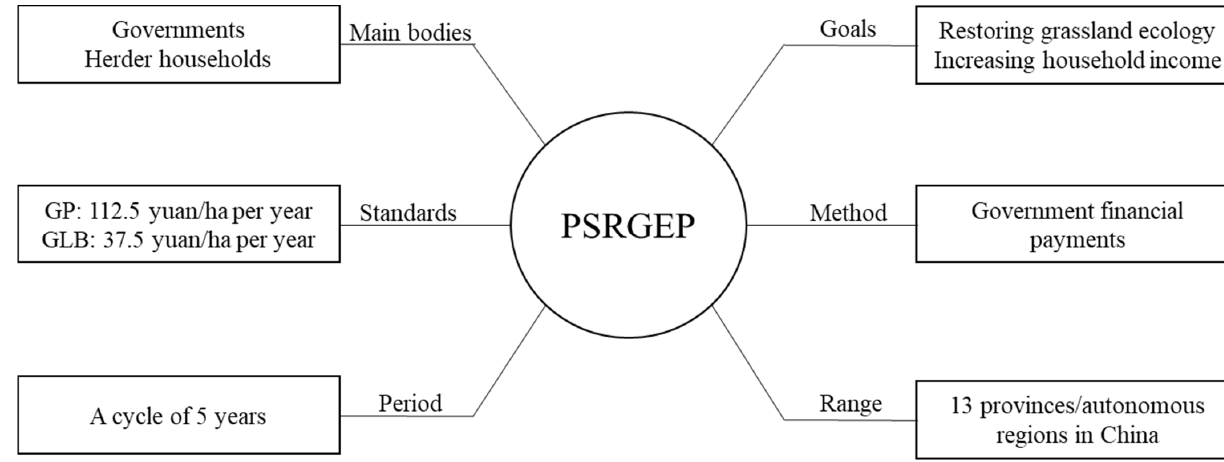
Figure 2. Overview of PSRGEP. Table 2. Grading criteria for compensation